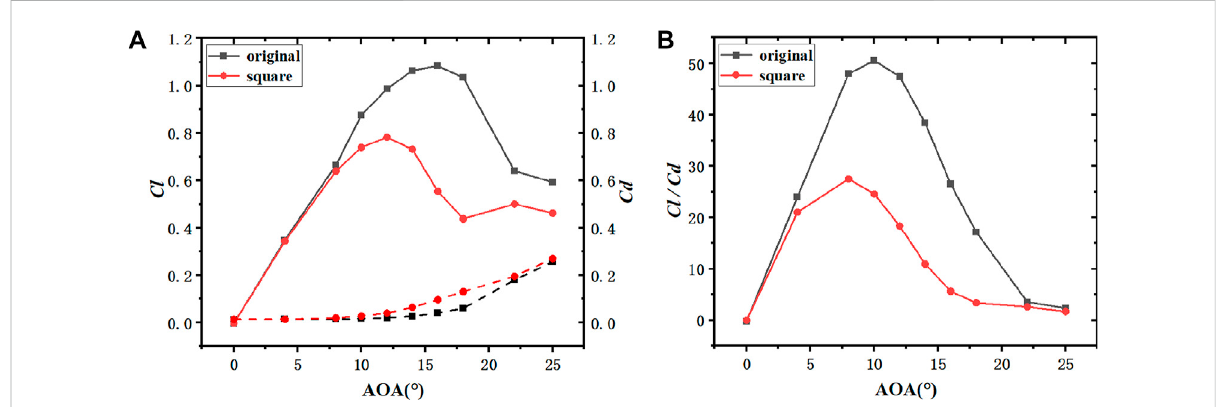
FIGURE 14 Comparison of aerodynamic characteristic curves between the original airfoil of NACA0021 and the square erosion airfoil with leading edge ( h